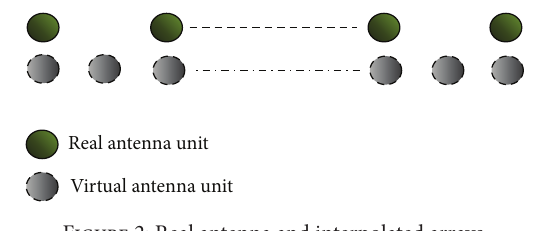
Figure 2: Real antenna and interpolated